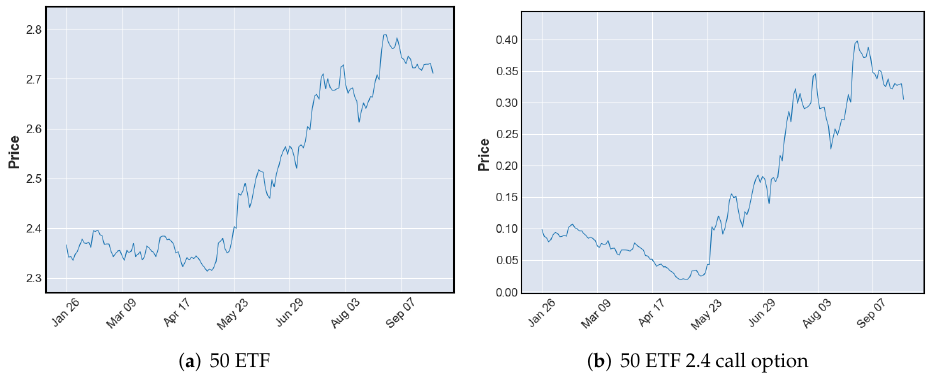
Figure 1. Price trend from 26 January 2017 to 27 September